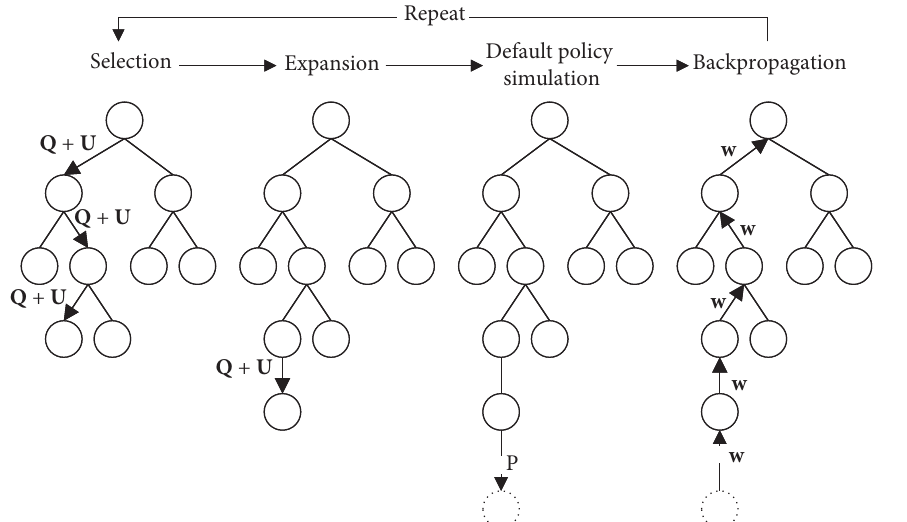
Figure 2: UCT algorithm for Jiu